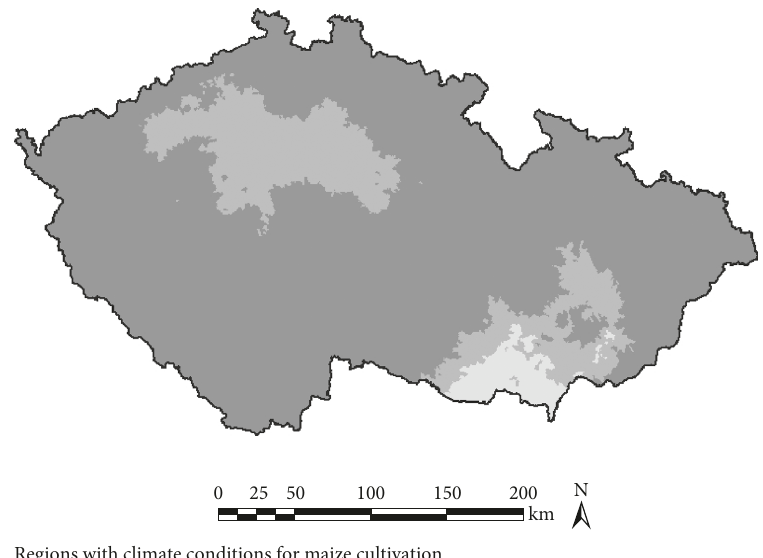
Figure 3: Prediction scenario of climate conditions for grain maize growing in the study region of the Czech Republic in the period 2011–2030, based on the regional biogeographical model.